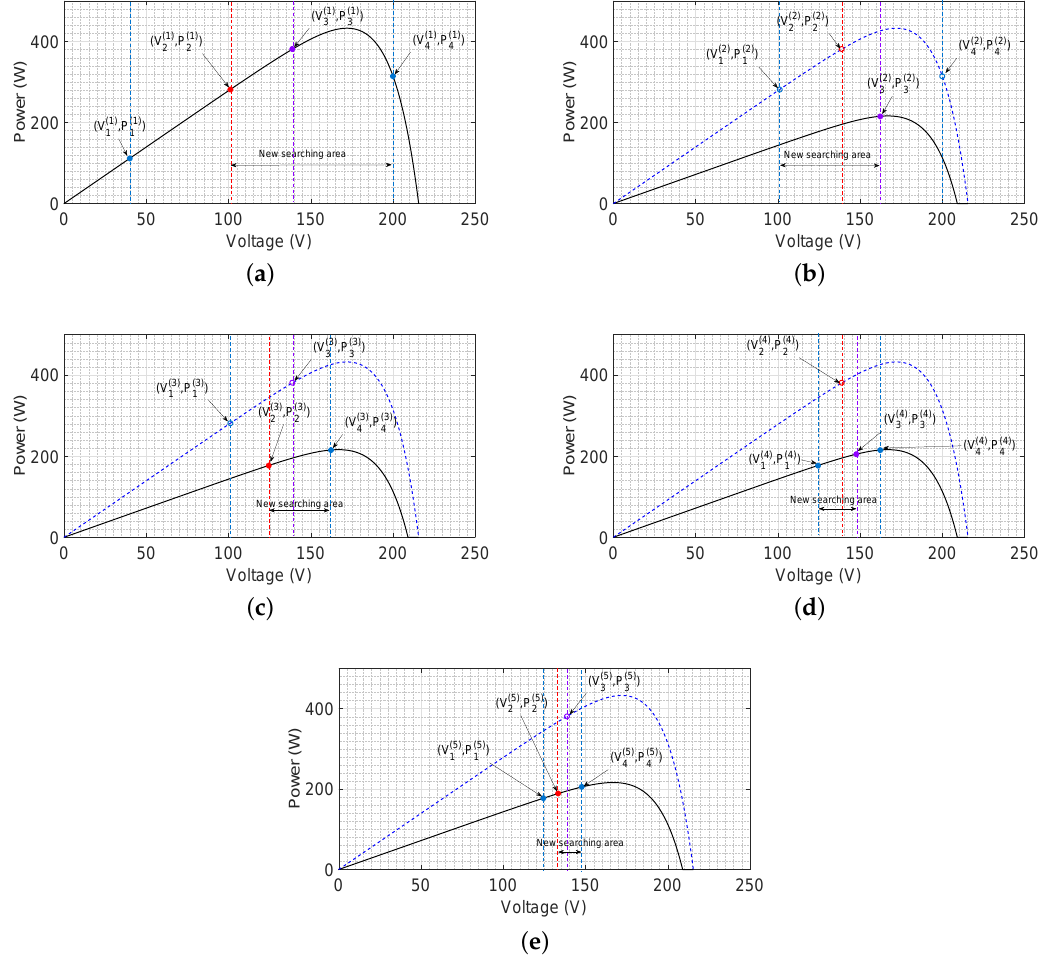
Figure 21. GSS under sudden irradiance changes. ( a ) 1st; ( b ) 2nd; ( c ) 3rd; ( d ) 4th; and ( e ) 5th iteration.